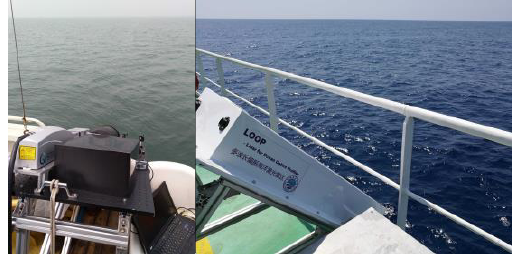
Fig 2. LOOP field experiment. The left is in Jiaozhou Bay and the right is in the South China